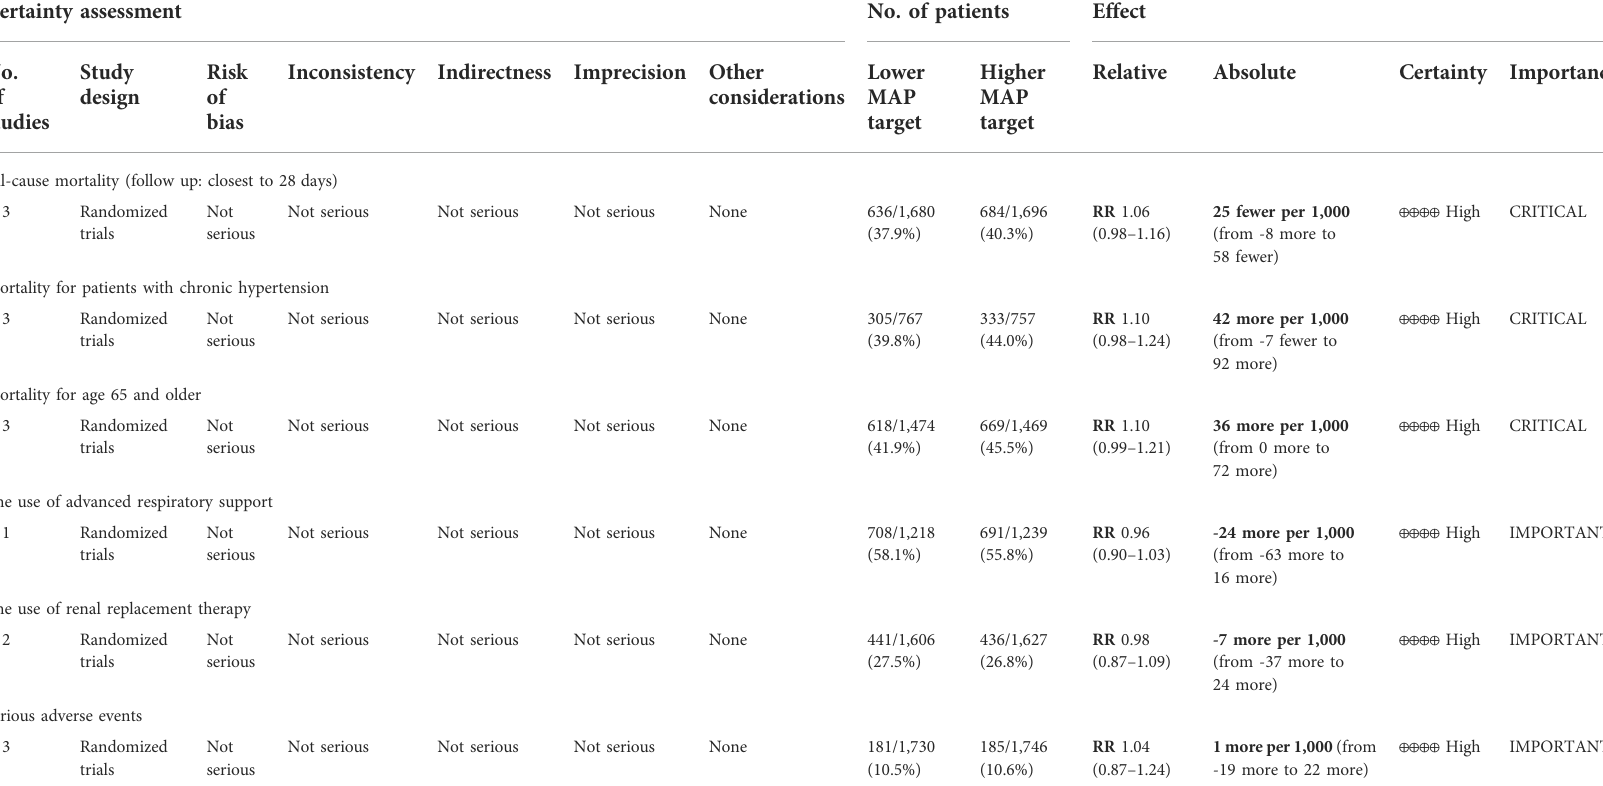
TABLE 2 GRADE evidence pro fi